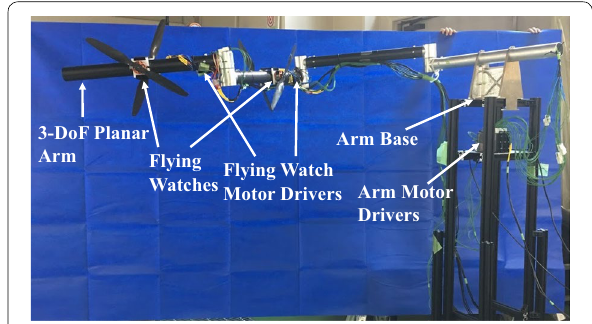
Fig. 6 PIA attached with two prototype flying